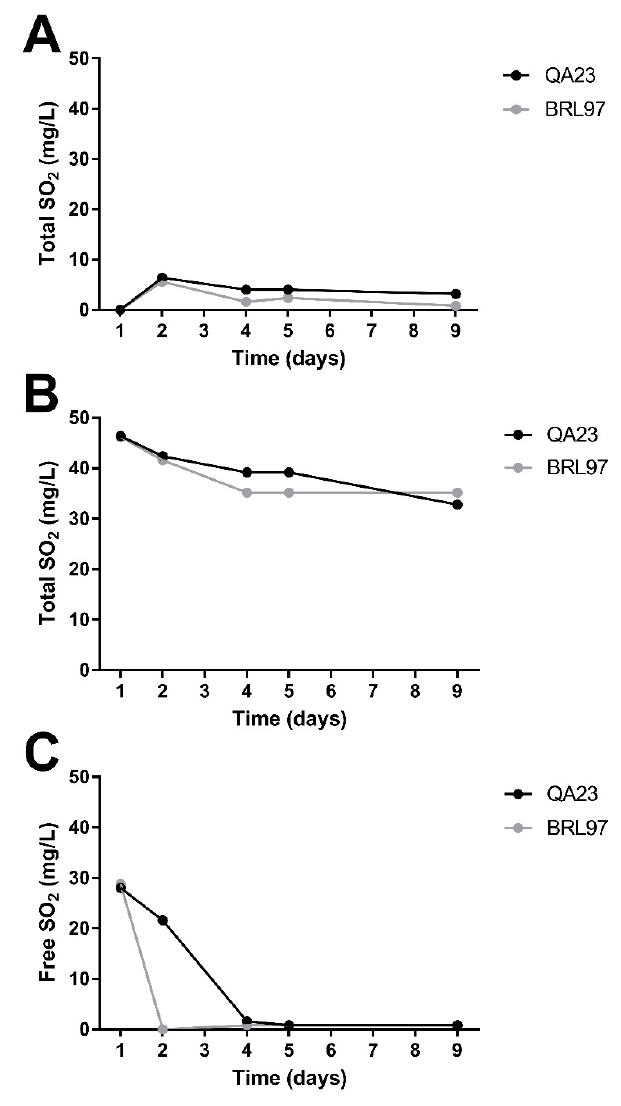
Figure 3. SO 2 levels (mg/L) throughout fermentations conducted by different yeast strains and in the presence of different levels of initial SO 2 . Wine samples from each of the four replicates were combined for SO 2 analysis due to volume constraints. Plots represent ( A ) total SO 2 produced by yeasts throughout fermentations containing 0 mg/L SO 2 ; ( B ) total SO 2 levels throughout fermentations containing 50 mg/L SO 2 ; ( C ) free SO 2 levels throughout fermentations containing 50 mg/L SO 2 .